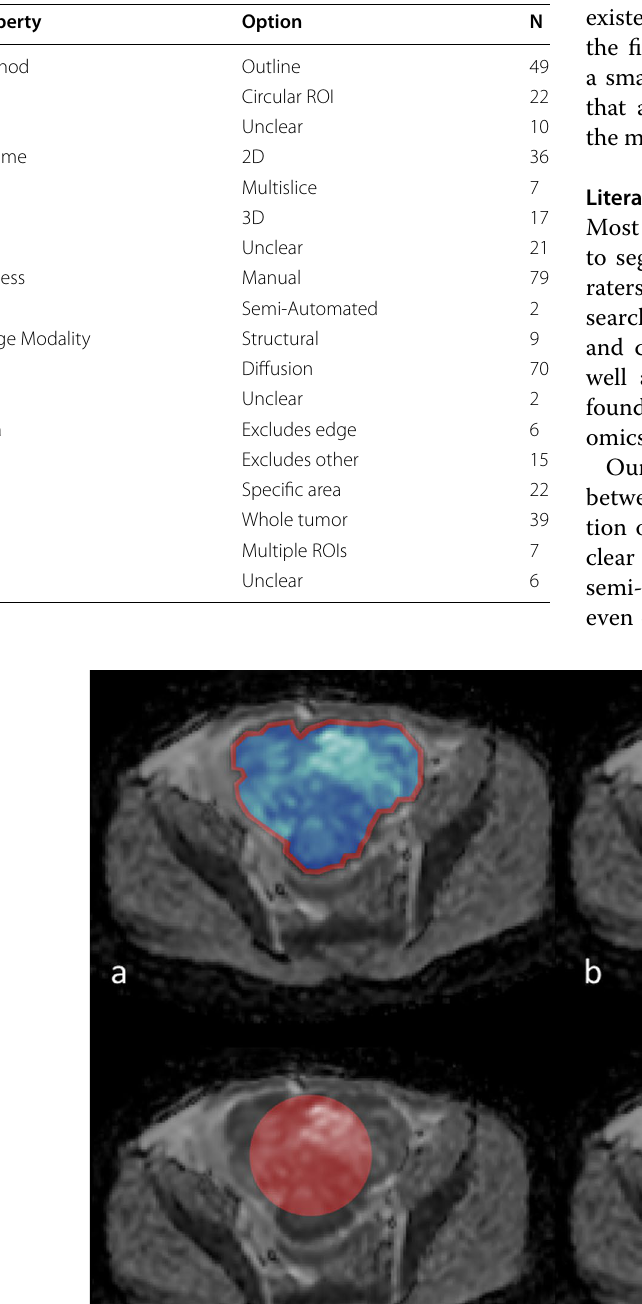
blue area. b ‘Inside solid’ strategy, blue area. ‘Solid’ strategy, red +